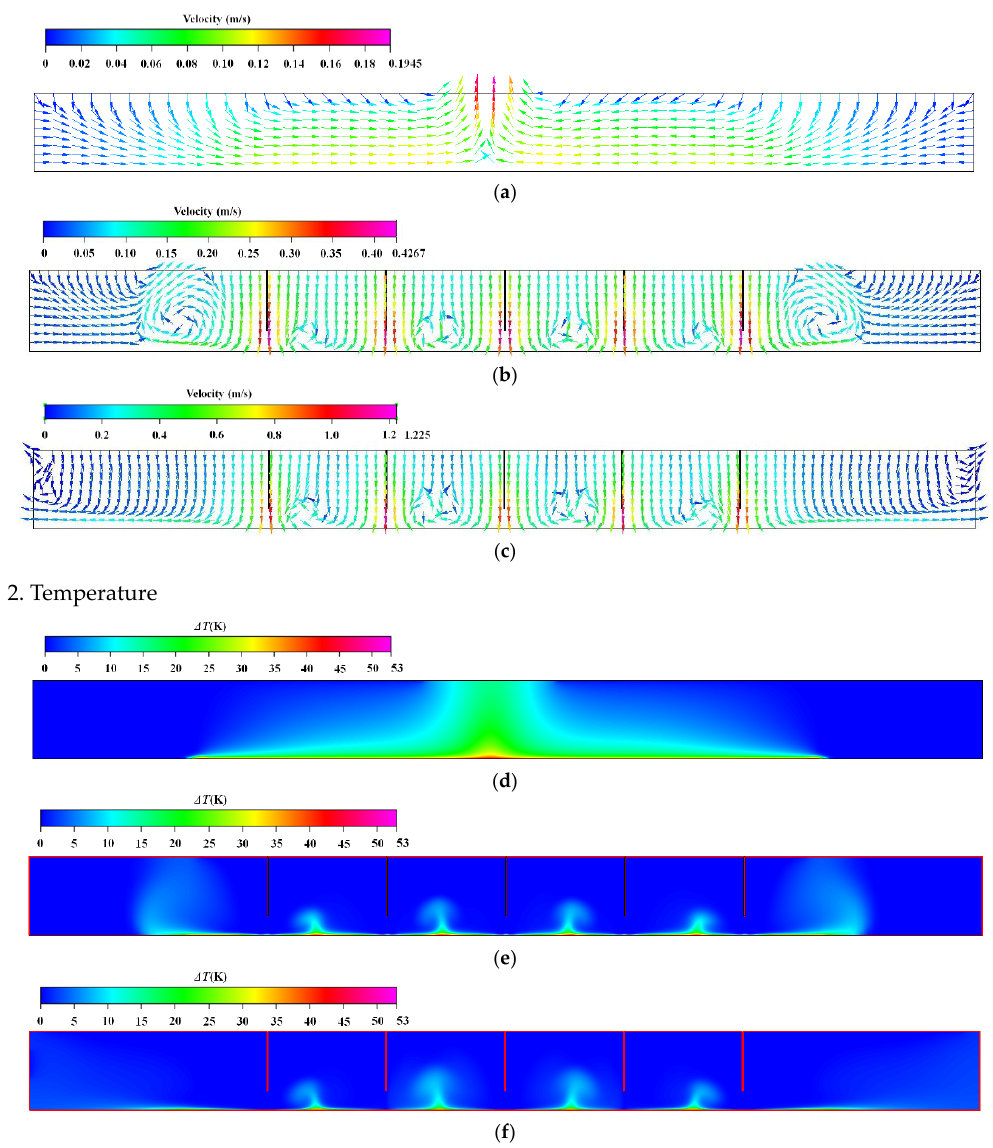
Figure 8. Distributions of flow vector and temperature for a specified x-y plane for electrode heights (Δ T = 53 K and SL = 150 mm). ( a ) Non EHD; ( b ) V 0 = 12 kV, H = 25 mm; ( c ) V 0 = 20 kV, H = 25 mm; ( d ) Non EHD; ( e ) V 0 = 12 kV, H = 25 mm; ( f ) V 0 = 20 kV, H = 25